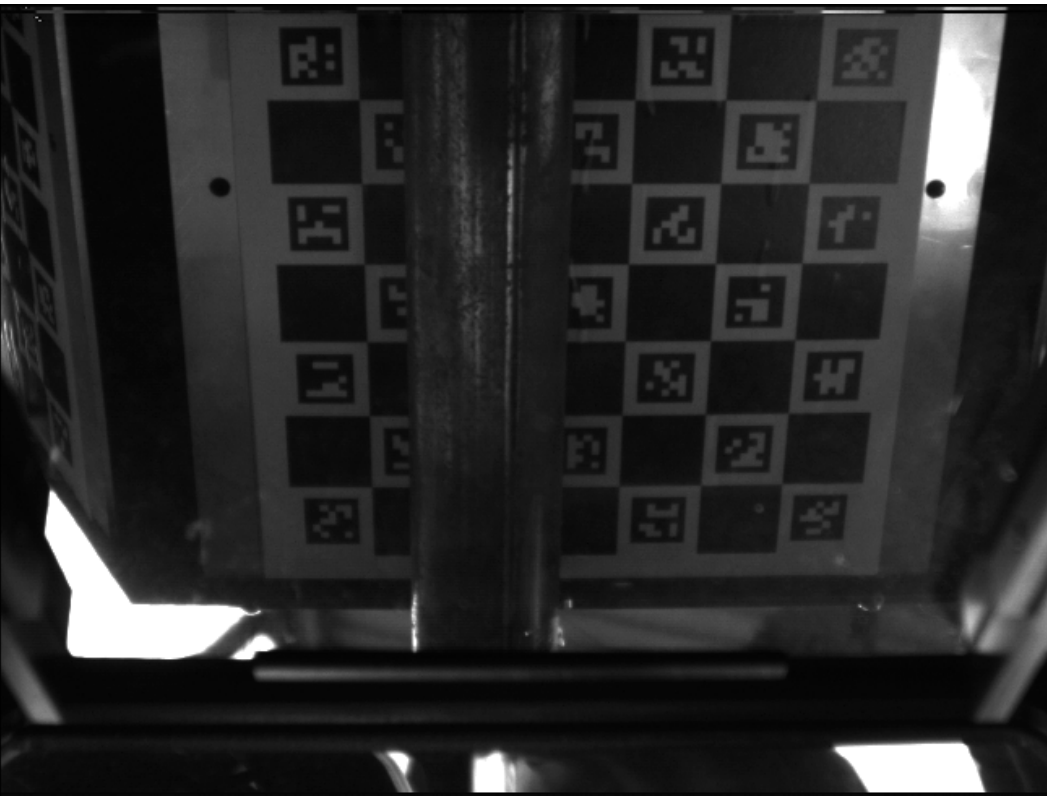
Figure 15. A view from the measurement head located at the bottom during the global calibration procedure. Some of the fields are occluded by the conveyor and therefore camera pose is estimated from a reduced set of chessboard corners and may be estimated sub-optimally.